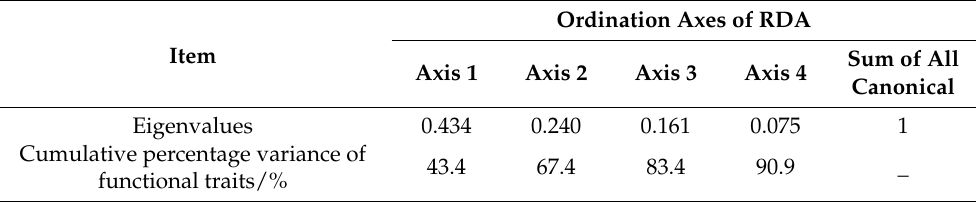
Table 4. Eigenvalues of the ordination axes and the cumulative percentage variance of functional trait–environment relation explained by ordination axes.